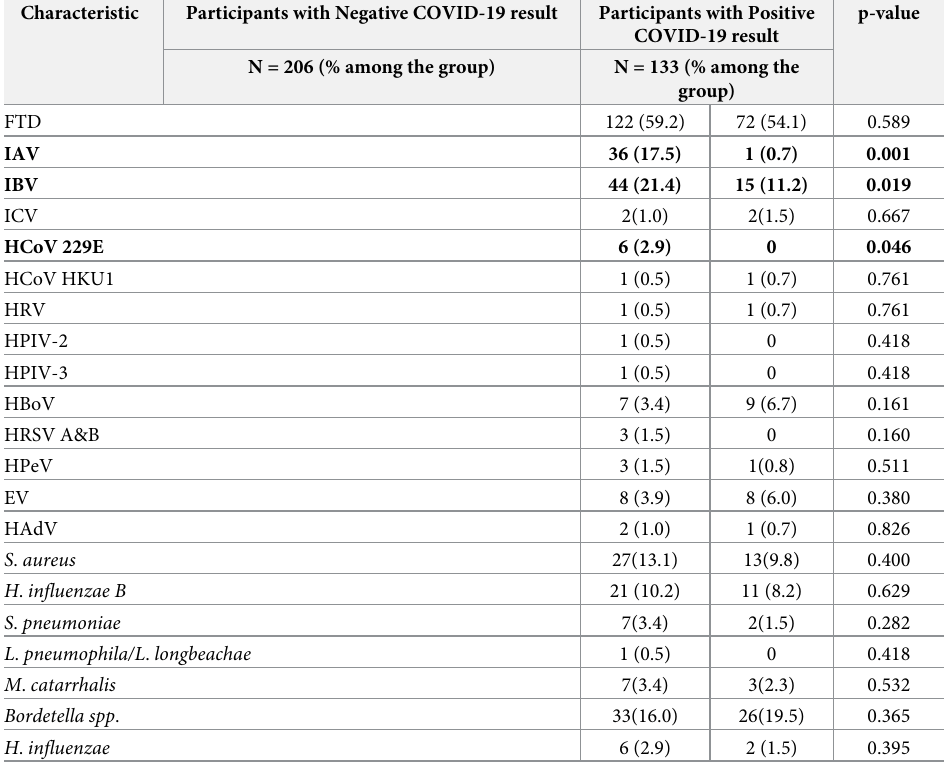
Table 6. Comparison among study participant groups test results regarding both SARS-CoV-2 and FTD patho- gens coinfection using Pearson X 2 test analysis. Characteristic Participants with Negative COVID-19